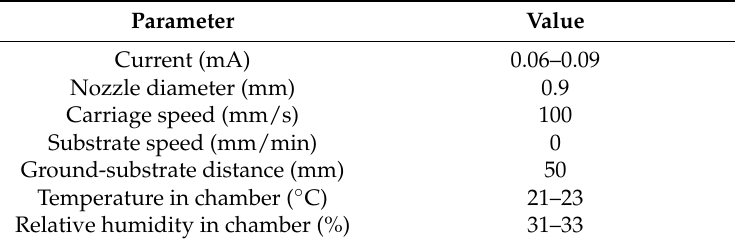
Table 2. Spinning